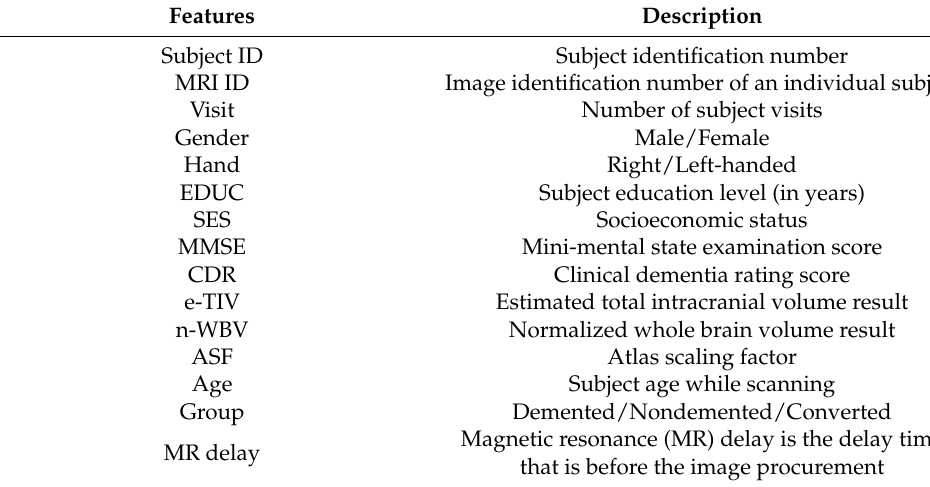
Table 3. Dataset feature